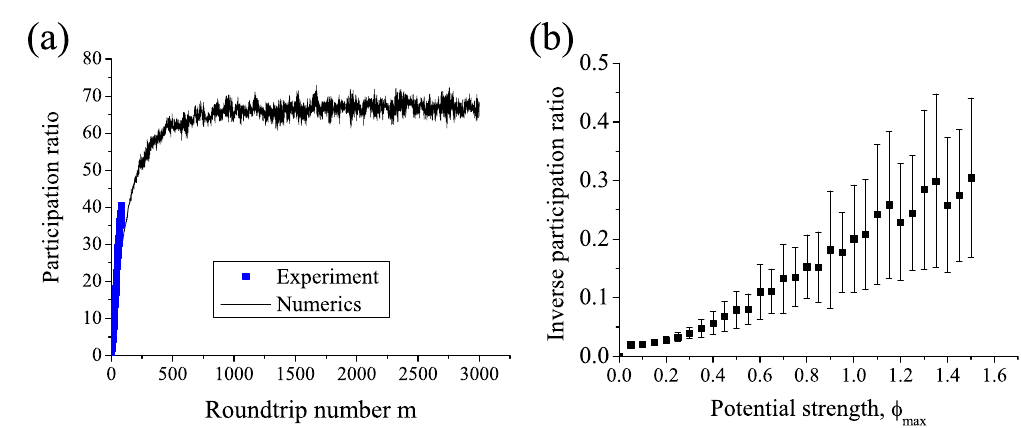
Figure 3. ( a ) Participation ratio calculated for the case of a weak potential realization with φ max = 0.2 π . ( b ) Inverse participation ratio, numerically derived and averaged over 100 realizations of random potential with different strengths for m =